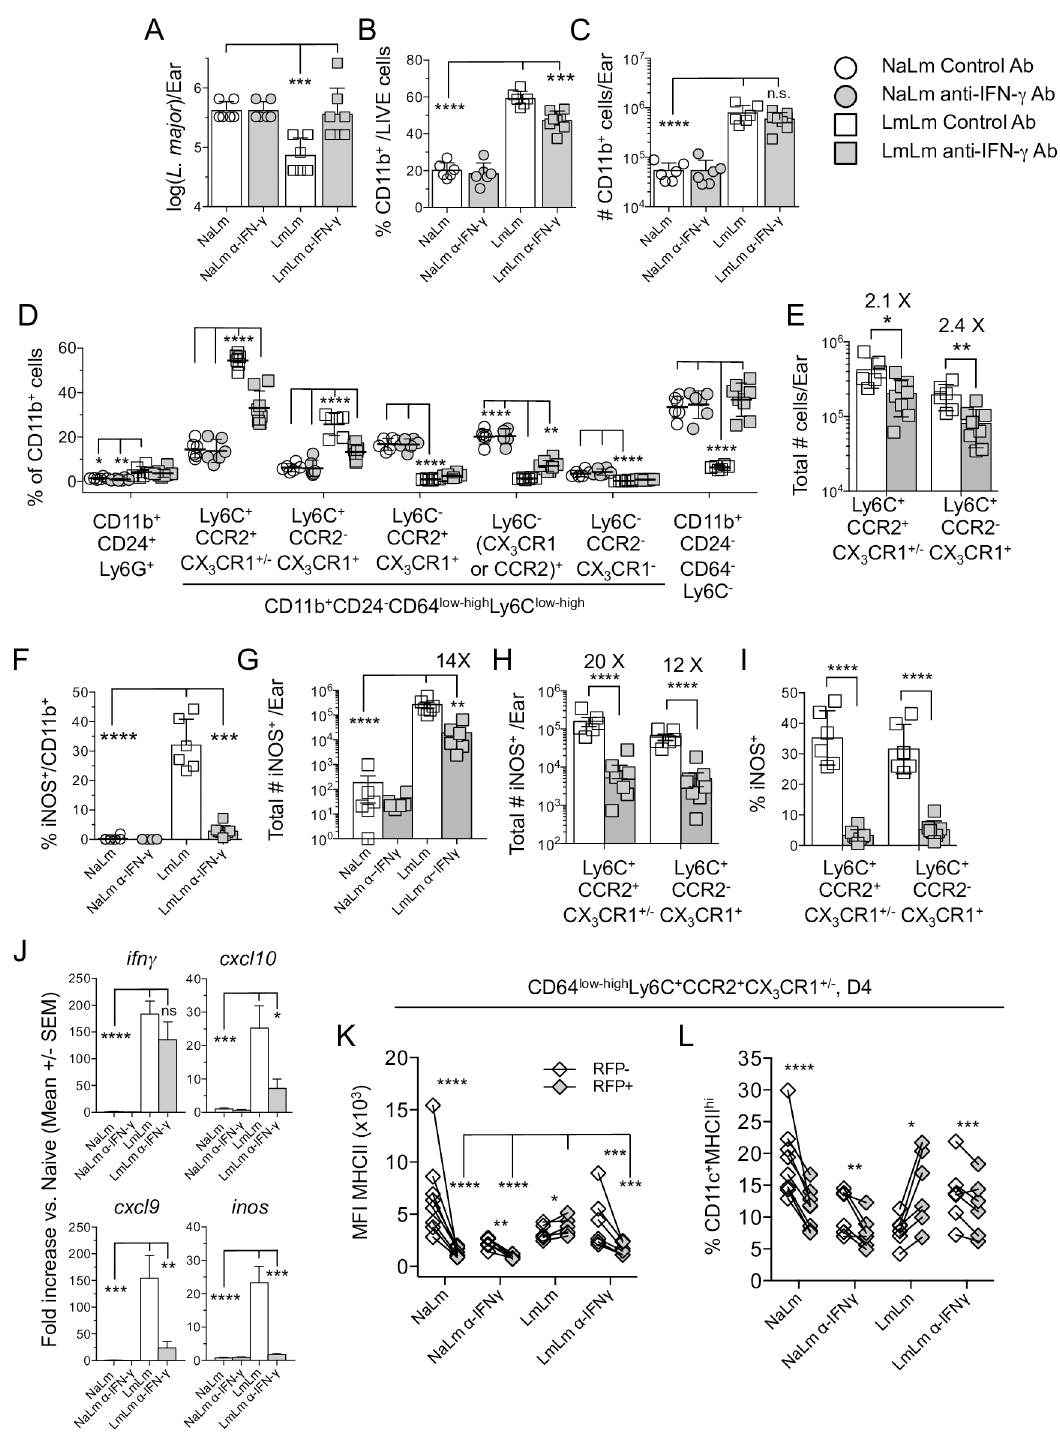
Fig 6. Interferon- γ drives chemokine expression, monocyte recruitment, iNOS-production and parasite killing at sites of secondary challenge. Mice as describedin Fig 4 were treated with 0.5mg i.p. anti-IFN- γ or control antibody on day -1 and analyzedon day 4 post-ch. (A) Parasite load per ear determined by LDA. (B and C) Frequency (B) or absolute number(C) of CD11b + cells per ear. (D) Frequency of the indicatedpopulationswithin the total CD11b + populationper ear. (E) Absolute numberof the indicatedmonocyte populationsper ear. (F and G) Frequencyof iNOS + within total CD11b + cells (F) and absolute numberof CD11b + iNOS + cells (G) per ear. (H) Absolute numberof the indicatediNOS +